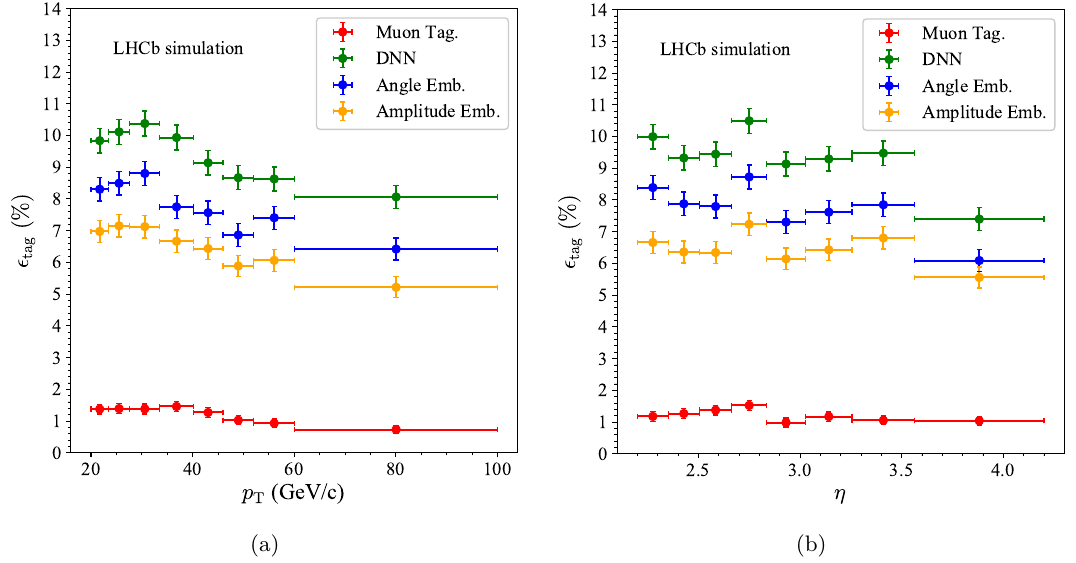
Figure 8. Tagging power (cid:15) tag with respect to (a) jet p T and (b) jet η for the complete dataset . The quantum algorithms perform slightly worse than the DNN, with the Angle Embedding circuit performing better than the Amplitude Embedding